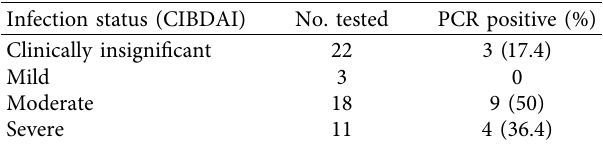
Table 2: Descriptive statistics of the occurrence of Campylobacter species infection in puppies based on the Canine Infammatory Bowel Disease Activity Index (CIBDAI) clinical scoring